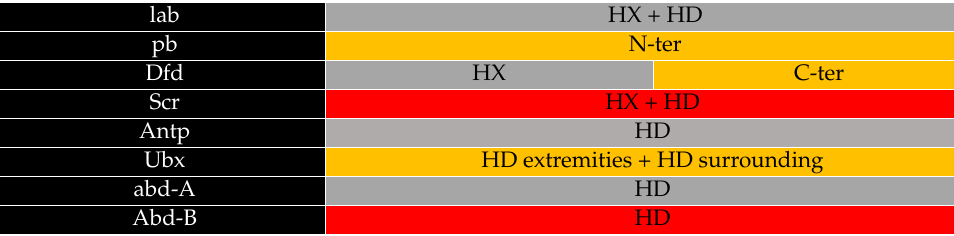
Table 2. Best score predictions for NLS sequences of Drosophila HOX proteins, generated by cNLS mapper [48]. (HX, hexapeptide; HD, homeodomain; N-ter, N-terminus; C-ter, C-terminus; Score: grey >3–5 ≥ ; orange >5–7 ≥ ; red >